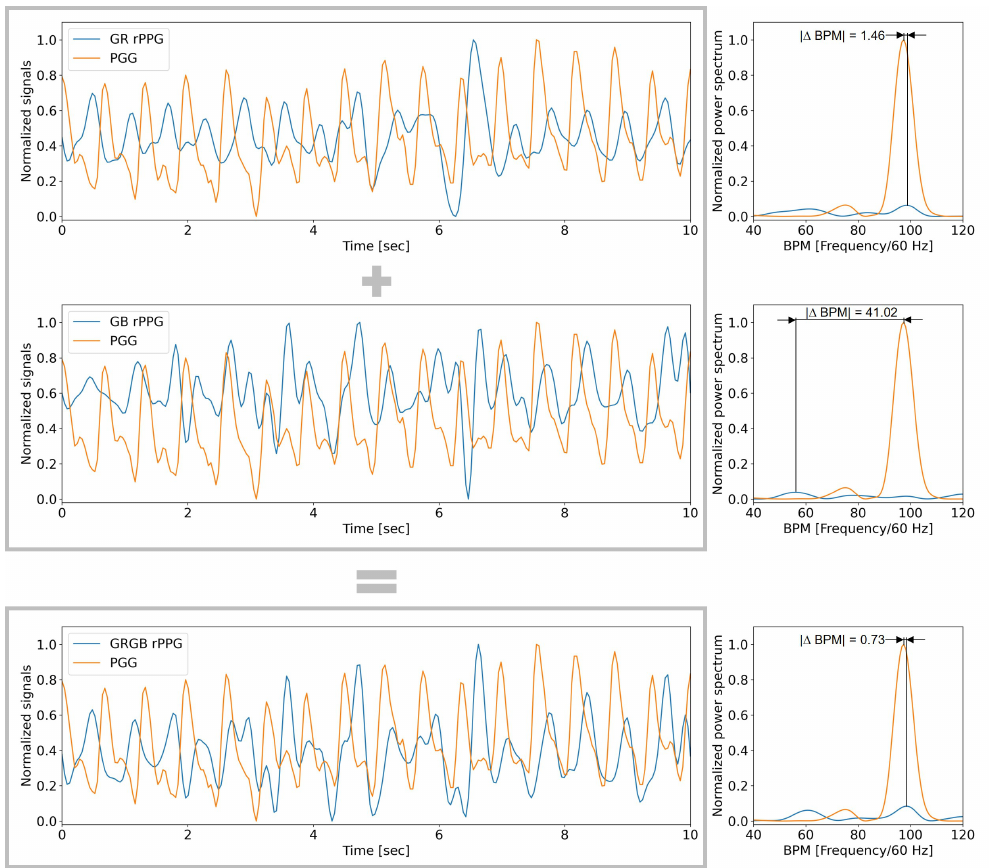
Figure 2. Representative normalized rPPG signals of the three proposed methods from a 10-second window in the Gym video setting of the participant, David, and the reference fingertip PPG signal. The combination of the GR and GB method results in the GRGB